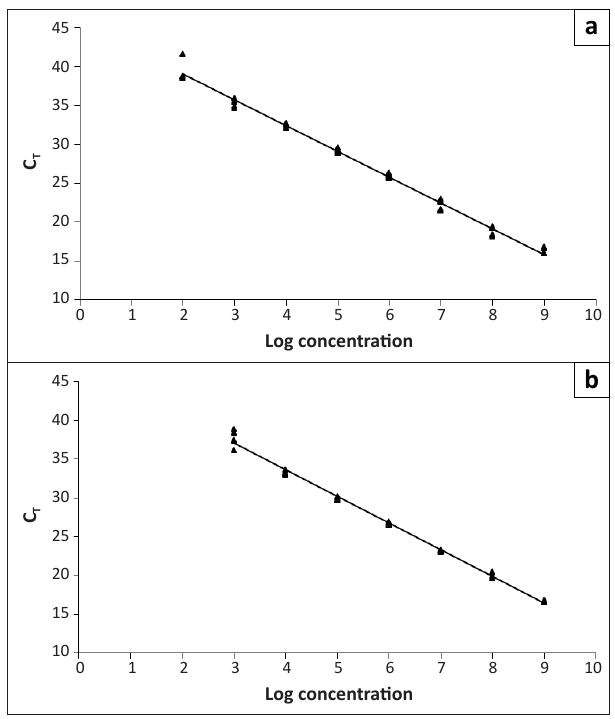
FIGURE 3: Linear regression of six replicates of (a) IGF1R and (b) INSR standard curves (from CT RT-PCR results).